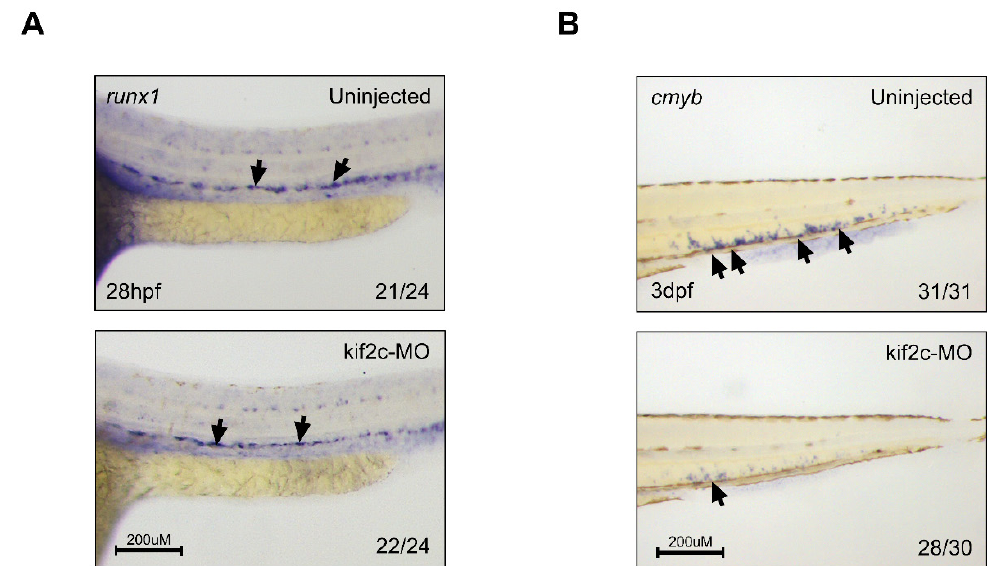
Figure 5. kif2c is related to the maintenance of hematopoietic stem cells . ( A ) Whole-mount in situ hybridization of uninjected embryos and kif2c -targeting morpholino-injected embryos at 28 hpf using runx1 probe. Black arrows indicate the signal of runx1 at dorsal aorta. ( B ) Whole-mount in situ hybridization uninjected embryos and kif2c -targeting morpholino-injected embryos at 3 days post fertilization (dpf) using cmyb probe. Black arrows indicate the signal of cmyb at caudal hematopoietic tissue.